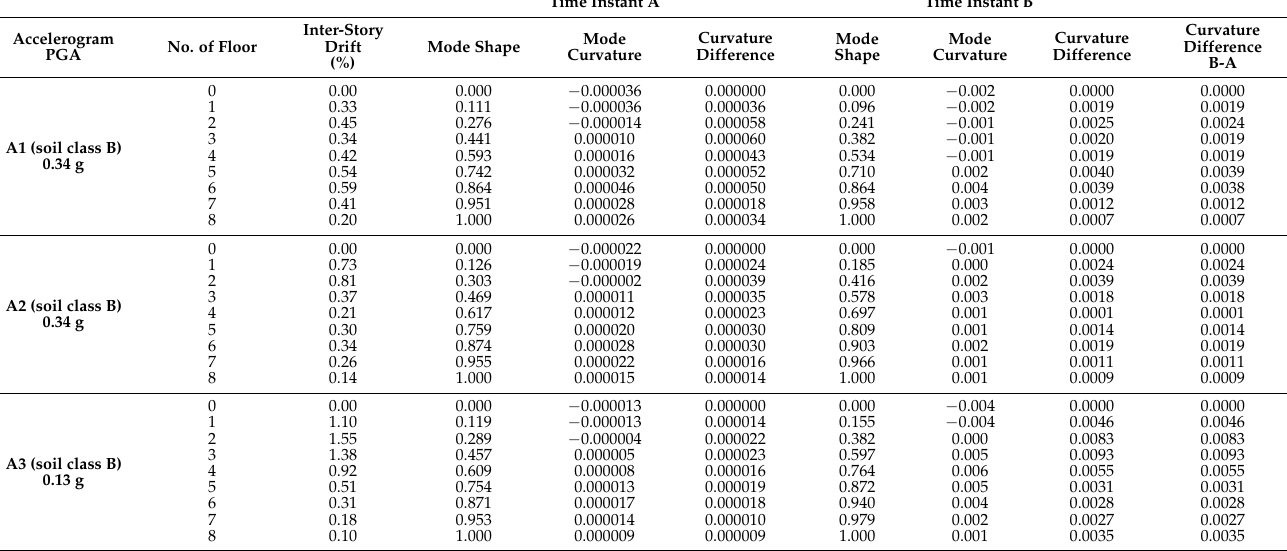
Table A4. Values of the main parameters evaluated for the 8-story numerical model in correspondence to the fundamental mode of